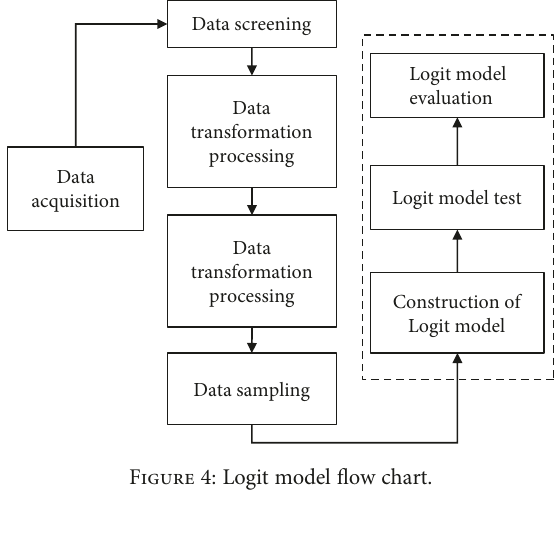
Figure 4: Logit model fl ow chart.